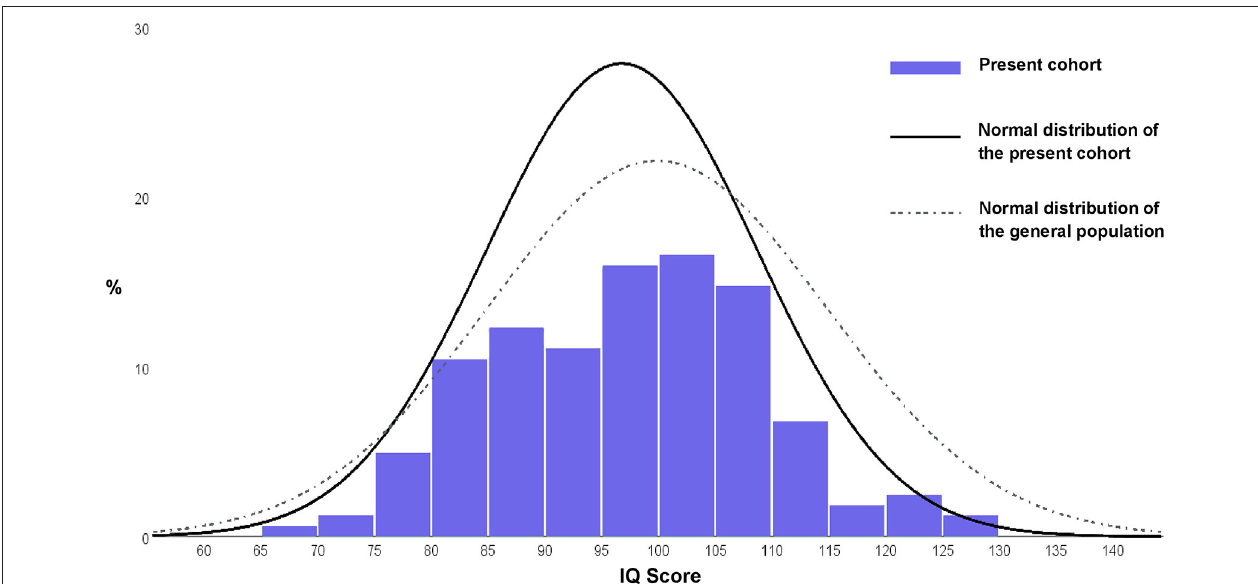
FIGURE 1 | Histogram of the distribution of IQ scores in the present cohort compared with the theoretical distribution of the general population. One participant with IQ < 70 was included in the histogram.